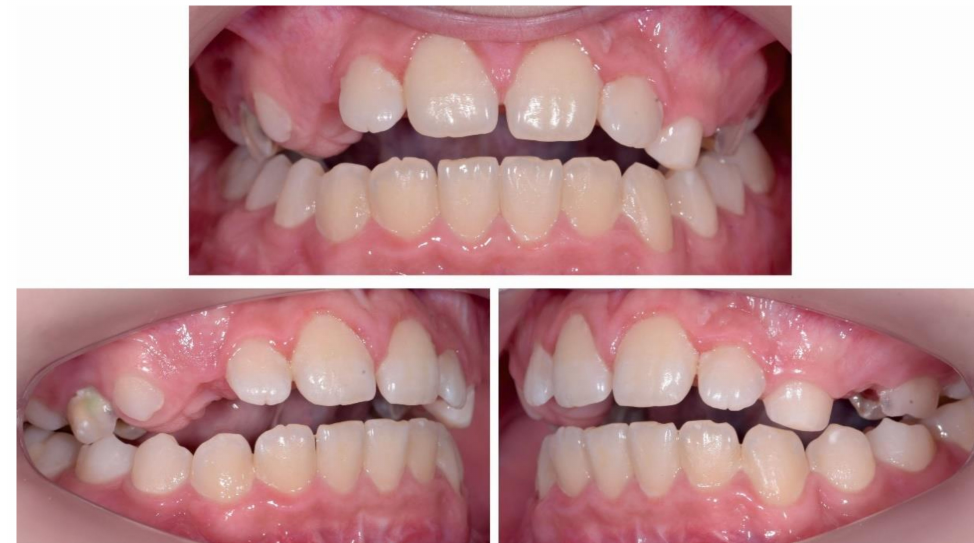
Figure 13. Post-splint therapy evaluation—intra-oral photographs.